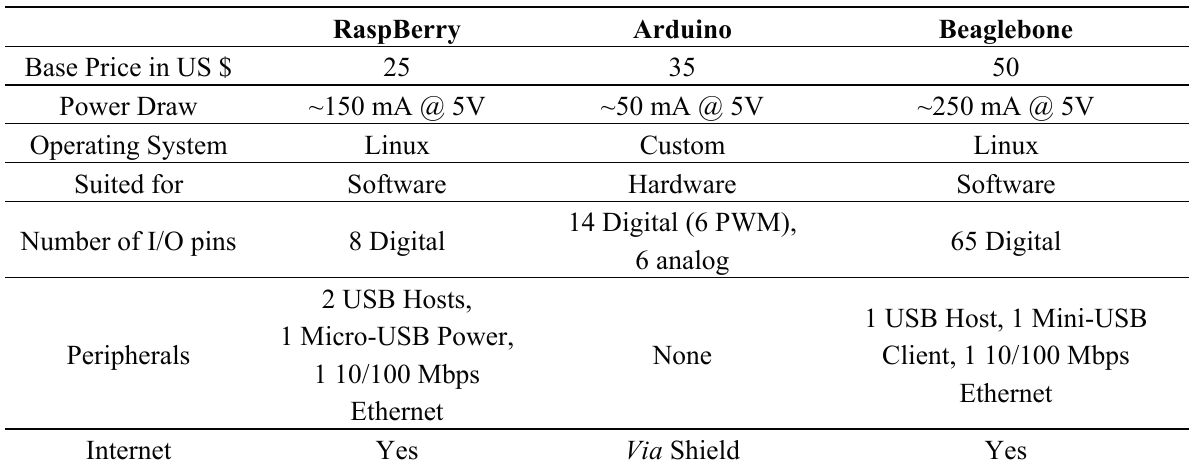
Table 2. Raspberry-Pi vs. Arduino and Beaglebone. RaspBerry Arduino